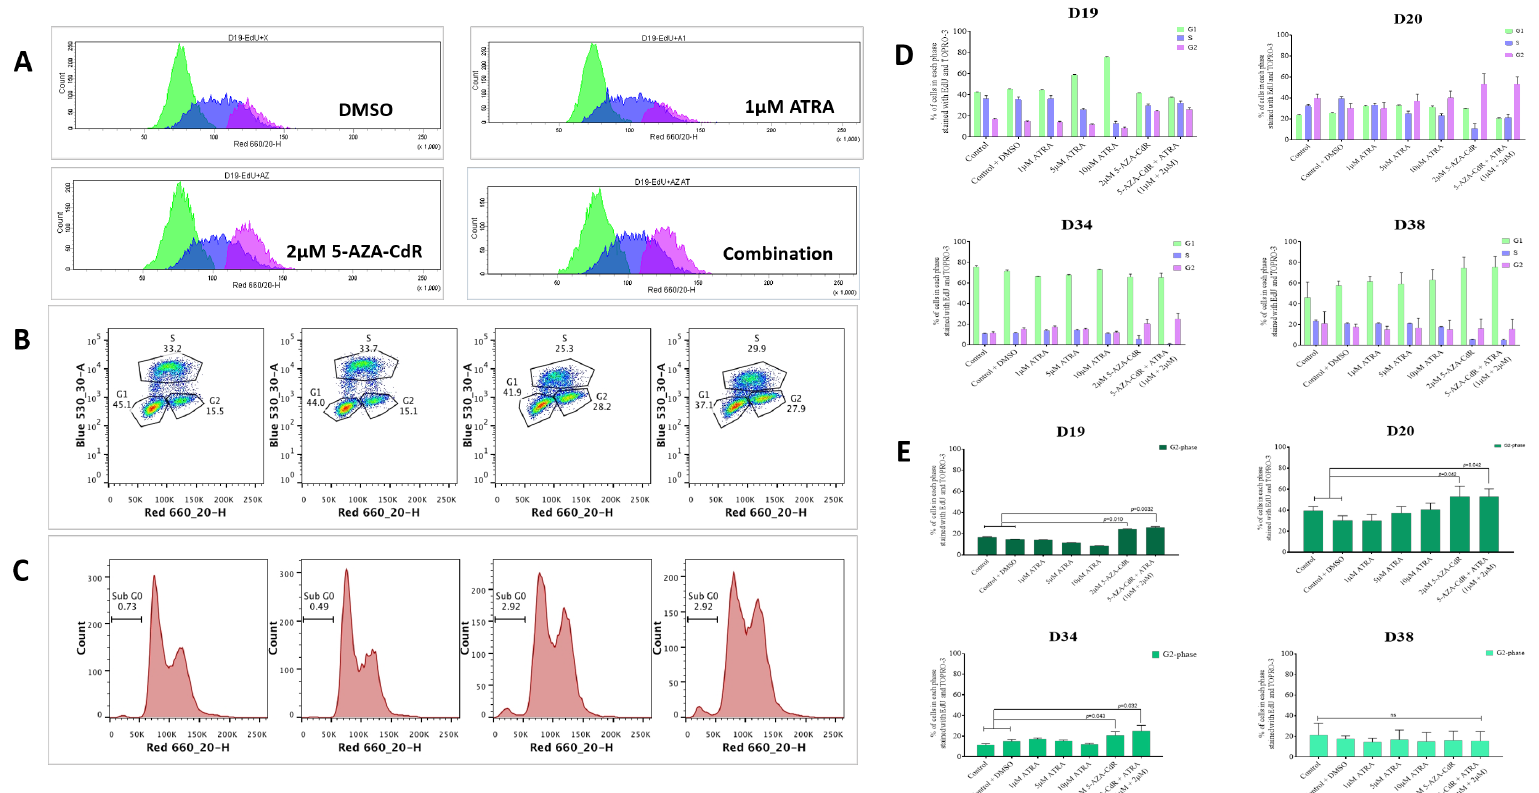
Figure 5. Cell cycle analysis and the sub-GO content by flow cytometry. ( A ) A representative image of cell cycle analysis showing G1-S-G2M peaks assessed by flow cytometry with EdU in ATRA and 5-AZA-CdR treated D19 cells. ( B ) A representative flow cytometry dot plot of EdU-labelled D19 following treatment with ATRA, 5-AZA-CdR, and a combination of 5-AZA-CdR with ATRA showing a slowdown of cell turnover and G2-M arrest. ( C ) Representative histogram of treated D19 cell line highlighting sub-G0 content of fragmented DNA from the apoptotic cells. ( D ) The bar charts represent a summary of the proportions of cells in cell cycle phases G1, S, and G2 in D19, D20, D34, and D38 under various treatment conditions. ( E ) The bar chart represents the cell turnover with ATRA and a block in G2/M phase transition with 5-AZA-CdR and ATRA. An increase in G2-M phase cell accumulation was noted in the D19, D20, and D34 cell lines ( p < 0.05), whereas no significant difference was noted in the D38 cell line by one-way ANOVA with post hoc Tukey’s